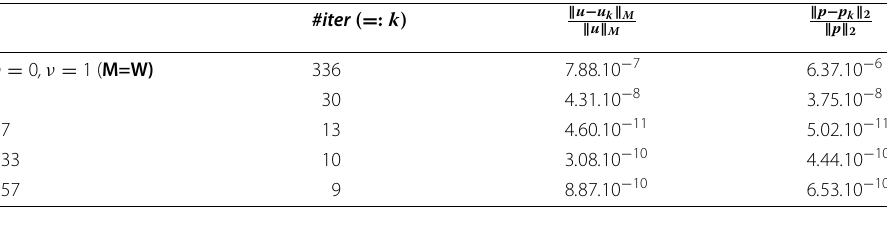
Table4 Different choices for ν for cylinder problem 4, (cid:6) GKB =1e − 5 and d = 5